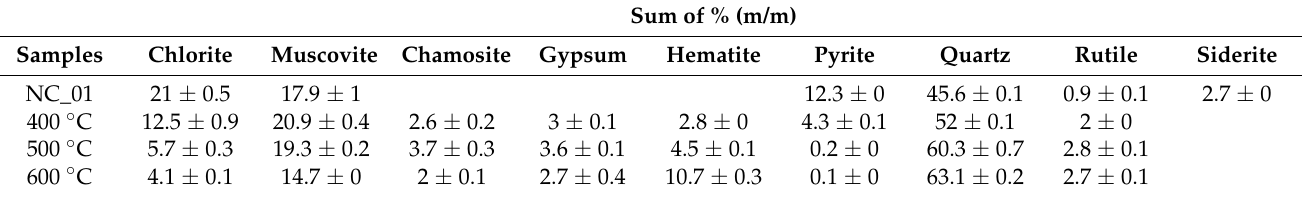
Table A12. Results from the XRD analysis of the Neves Corvo waste rock (NC_01) before and after microwave roasting at 400, 500 and 600 ◦ C.